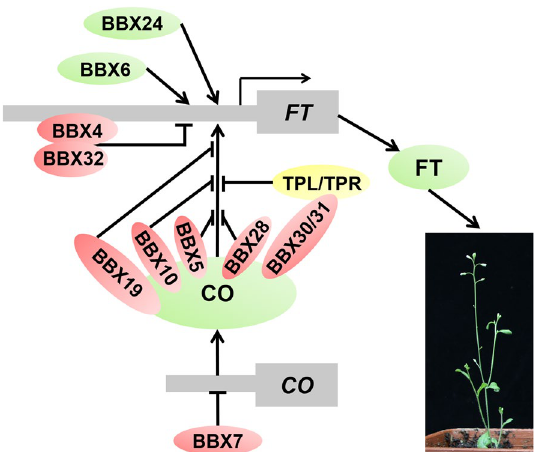
Fig. 3 BBX proteins-mediated flowering. CO, BBX6, BBX24 promote flowering via activate FT expression, whereas BBX7 inhibits flowering through repressing the expression of CO . BBX5, BBX10, BBX19, and BBX28 interact with CO to repress its transcriptional activity, resulting in delaying flowering. BBX30 and BBX31 act as scaffold to bridge CO and TPL/TPR, leading to block the transcriptional activation activity of CO towards FT . BBX proteins in red circle such as BBX4,